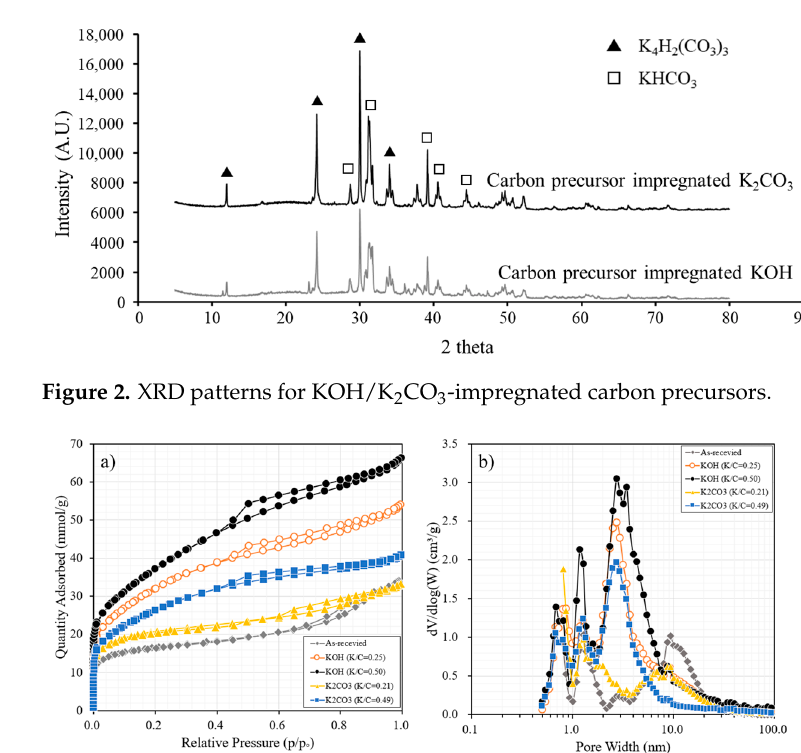
Figure 3. ( a ) N 2 isotherms and ( b ) pore size distributions of activated carbons prepared by impregna- tion with KOH and K 2 CO 3 at different K/C molar